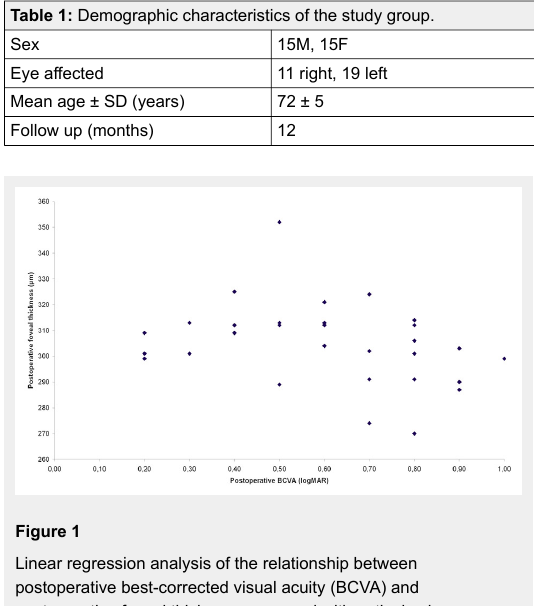
Linear regression analysis of the relationship between postoperative best-corrected visual acuity (BCVA) and postoperative foveal thickness assessed with optical coherence tomography (OCT). No correlation was observed between these two variables (Pearson’s correlation coefficient, r = 0.228; p =